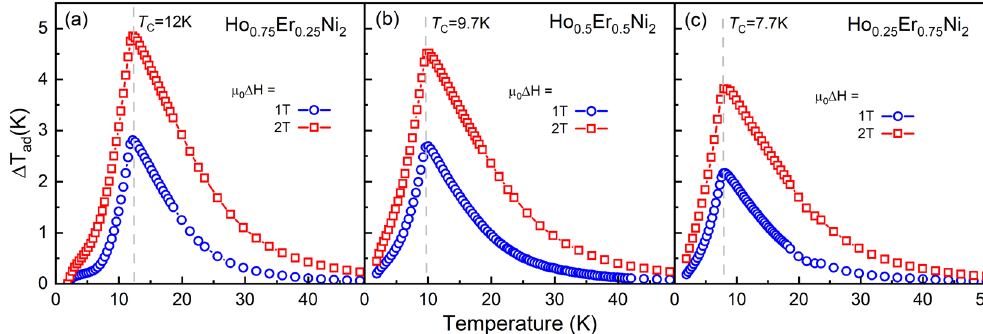
Figure 4. Temperature dependences of the adiabatic temperature change, Δ T ad , of Ho 0.75 Er 0.25 Ni 2 ( a ), Ho